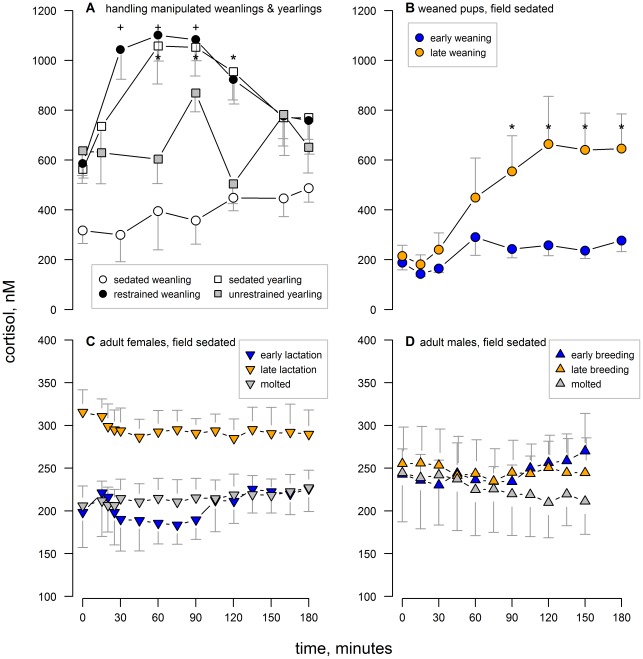
Cortisol concentrations during handling.The average cortisol concentration at each sample time within each study group; error bars represent standard errors. Note that the y-axis scales are different between the top and bottom graphs. RM ANOVA followed by pairwise post-hoc t-tests were used to test for significant differences from initial cortisol concentration. A) Handling manipulated group—physically restrained weanlings and chemically sedated yearlings showed increased cortisol levels during sampling. “+” and “*” indicate significant differences from initial (time = 0) cortisol value for physically restrained weanlings and chemically sedated yearlings, respectively (pairwise post-hoc t-test, p<0.05). B) Weaned pups early and late in post-weaning fast—late in the post-weaning fast, pups showed increased cortisol concentrations after 100 minutes of chemical sedation. “*” indicates significant difference from initial cortisol value (pairwise post-hoc t-test, p<0.05). C) Adult females early and late in lactation and after molting and D) adult males early and late in the breeding season and after molting. There was no significant difference in cortisol concentration with sample time among the adult samples.